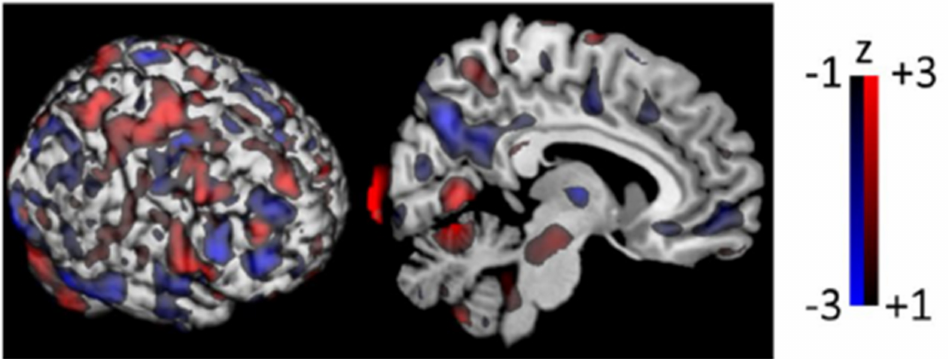
Figure 5. Visualization of the decision boundary for sequential minimal SVM on FDG-PET images of AD patients and healthy controls. Images scaled according to mean z-score and standard deviation of whole images for the purposes of visualization. Reprinted/adapted with permission from Ref.